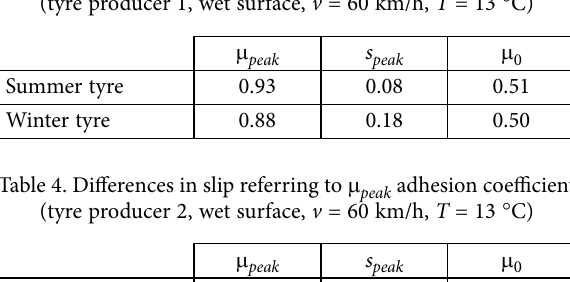
Table 3. Differences in slip referring to m peak adhesion coefficient